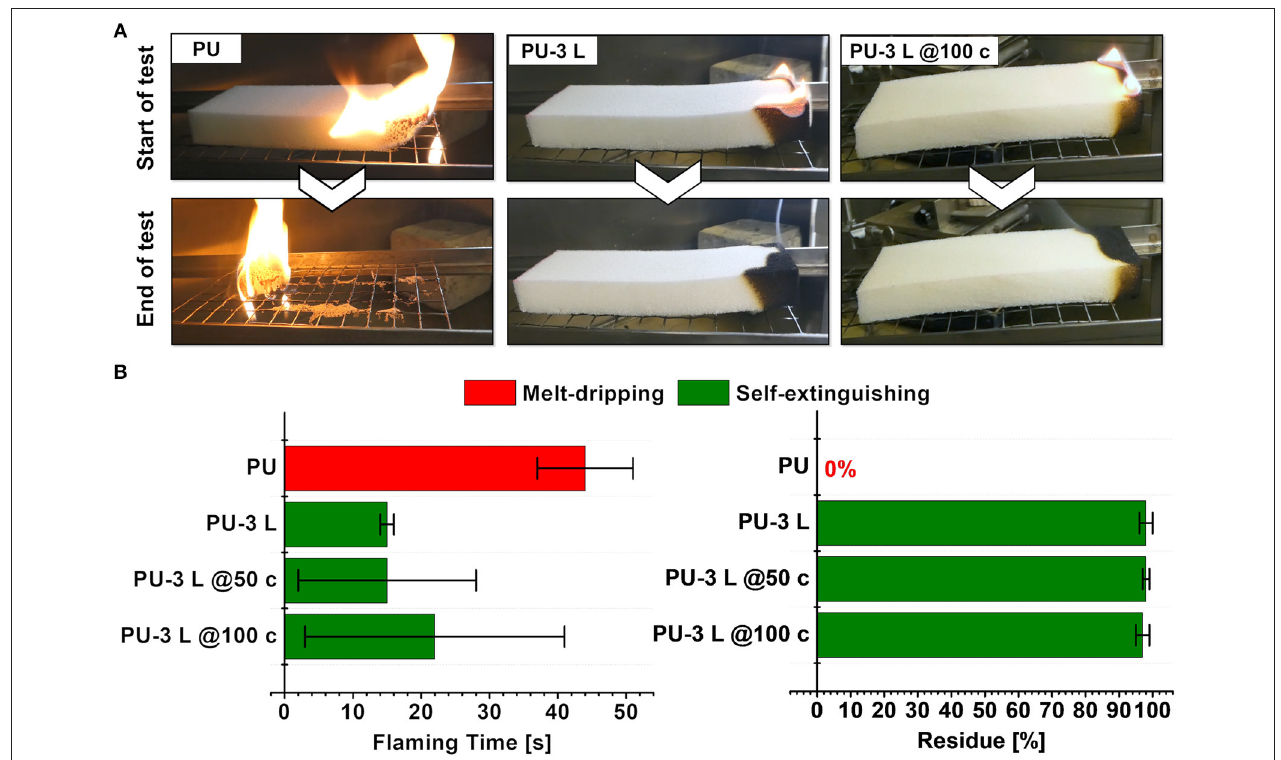
FIGURE 4 | Flammability tests performed on neat PU, treated PU, and treated PU foams after compression cycles; (A) snapshot of samples during the test, (B) flaming time and final residue.